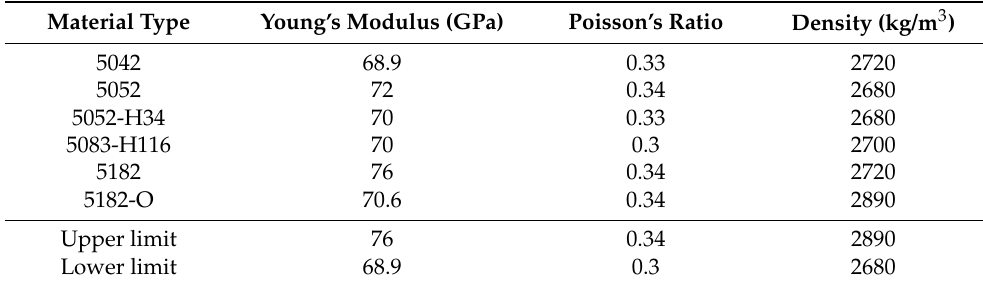
Table 7. Material properties of several typical Al–Mg alloys